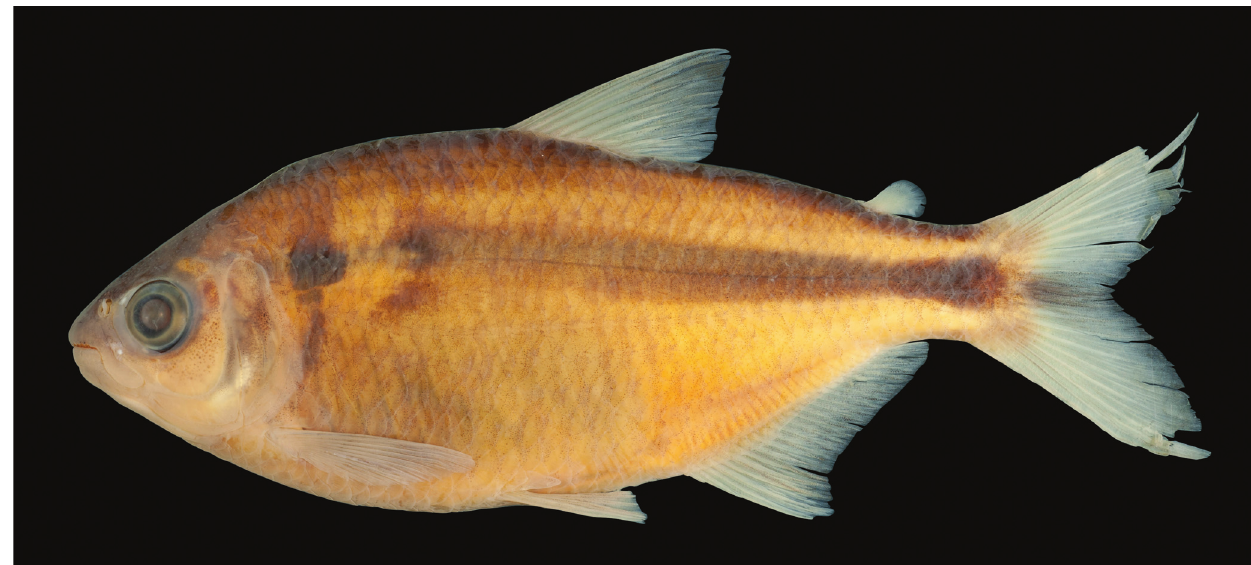
Fig. 4. Astyanax procerus , new species, MCP 47002, 101.8 mm SL, holotype, arroio Quebra Dentes at Quebra Dentes,